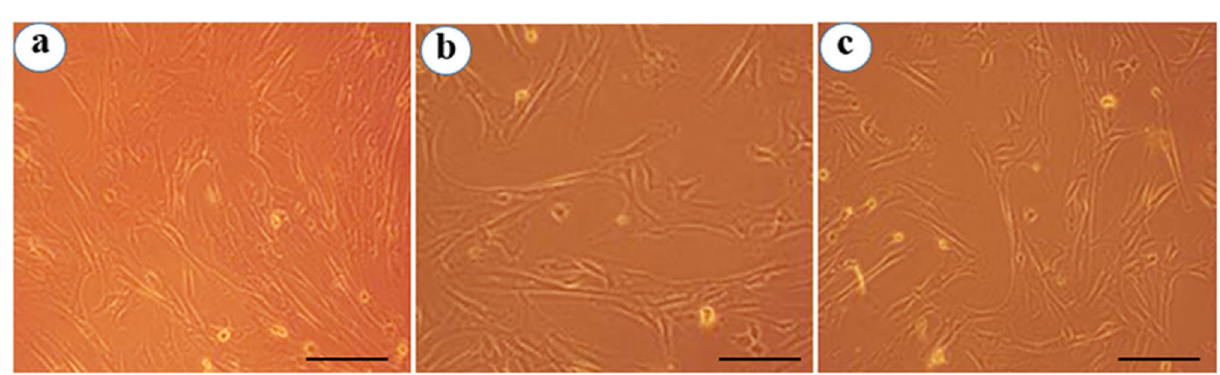
Figure 8. Cytotoxic activity of the highest concentration Pf-AgNPs and the extract of Perilla frutescens (600 µg/ mL) on L-929 cells. ( a ) Untreated cells, ( b ) Pf-AgNPs, ( c ) the extract of P. frutescens . (Scale bars represent 200